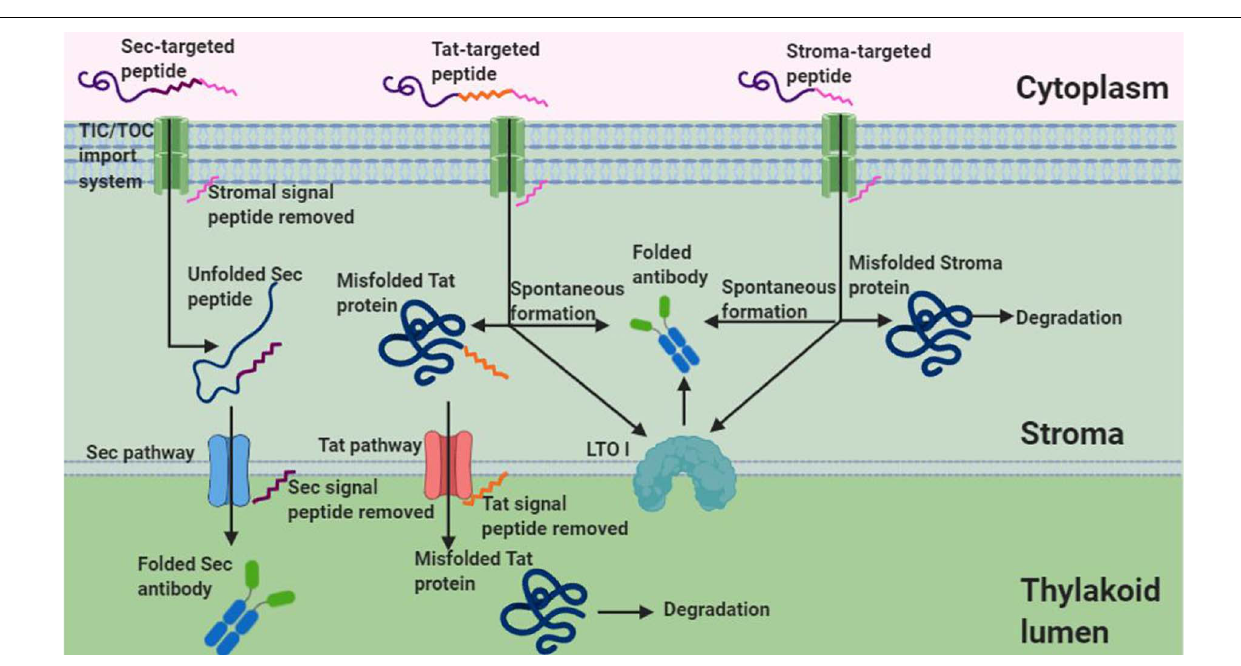
FIGURE 7 | Schematic of Sec, Tat, and stromal import of an antibody. Given that Tat and stromal imported antibodies retain functionality and show dimerized banding under non-reducing conditions, this suggests disulfide formation in the stroma despite its reducing environment. Shown are two possible mechanisms of disulfide formation, interaction with LTOI and spontaneous formation, that may account for disulfide formation of tat and stroma targeted antibodies (Figure created in